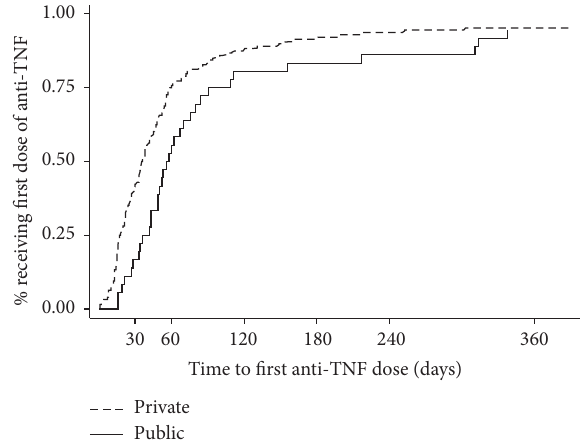
Figure 1: Kaplan-Meier curves for time to first dose of anti-TNF therapy stratified type of insurance drug coverage. Publicly funded subjects (solid line) experienced longer times to first anti-TNF dose than privately funded subjects (dashed line).